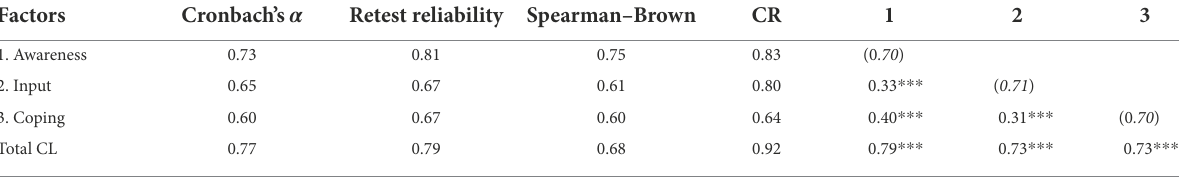
TABLE 4 Partial Correlations, Cronbach’s Alpha, Retest Reliability, and CR (and AVE’ Sqr for) Between SCLS’ Full-Scale and Subscale Scores. Factors